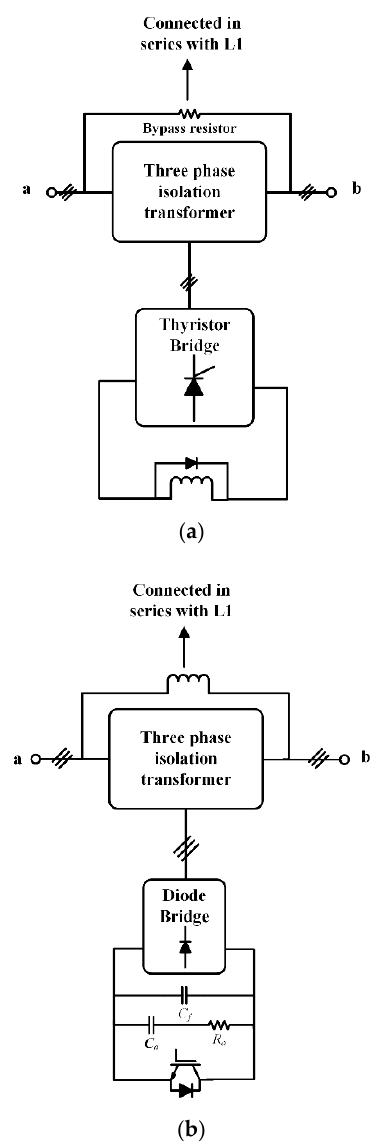
Figure 7. ( a ) The thyristor bridge type fault current limiter with bypass resistor (BTFCL-BR) [28]; and ( b ) the switch type fault current limiter (STFCL) with a snubber circuit [14].